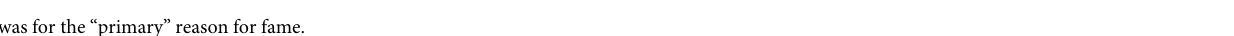
PLOS ONE | https://doi.org/10.1371/journal.pone.0252567 June 3,